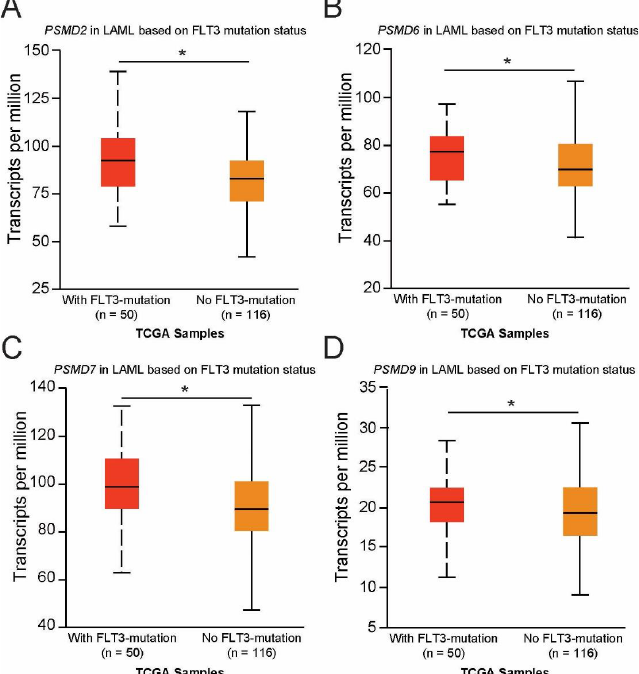
Figure 5. Correlation of PSMD2 , PSMD6 , PSMD7 , and PSMD9 mRNA expression with FLT3 mutation status in AML. ( A – D ) We used TCGA data available at UALCAN to associate the expression of other PSMD subunits with OS in AML. The box plots demonstrate that mRNA encoding PSMD2 ( A ), PSMD6 ( B ), PSMD7 ( C ), and PSMD9 ( D ) were significantly elevated in AML patients with mutated versus wild-type FLT3. Error bars represent SEM (* p < 0.05).